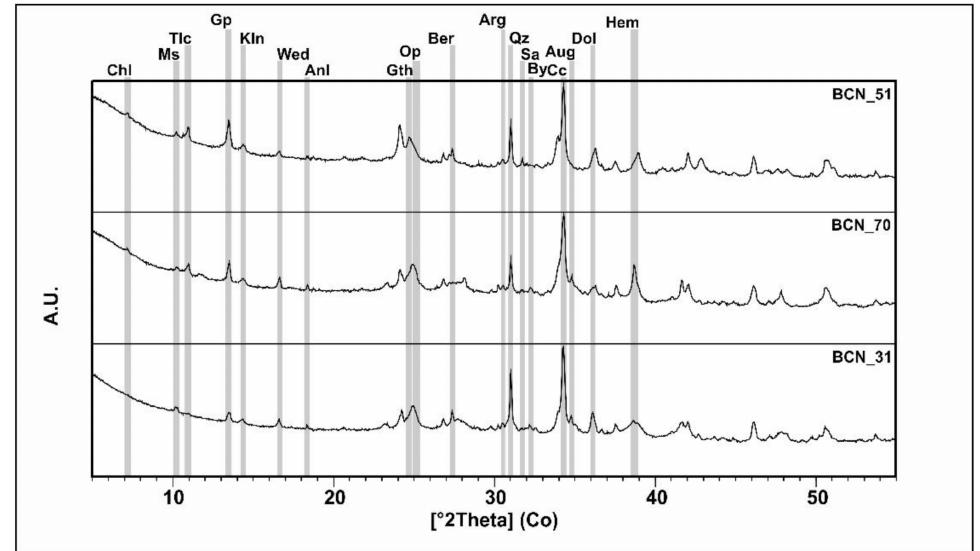
Figure 6. Representative XRPD patterns of the Herculaneum samples. The main reflexes of the identified minerals are indicated by the following abbreviations: Chl = chlorite, Ms = muscovite, Tlc = talc, Gp = gypsum, Kln = kaolinite, Wed = weddellite, Anl = analcime, Gth = goethite, Op = opal-CT, Ber = bernalite, Arg = aragonite, Qz = quartz, Sa = sanidine, By = bytownite, Cc = calcite, Aug = augite, Dol = dolomite, and Hem = hematite. Table 2. Results of the mineralogical quantitative phase analysis (expressed as wt.%), obtained by full profile fitting of the experimental X-ray powder diffraction (XRPD) patterns according to the Rietveld method. Chromophore to accessory phases ratios (C:A) of the ochres and values of hematite Lorentzian crystal size obtained through Rietveld refinement are also reported. Abbreviations reported in Figure 6 caption.